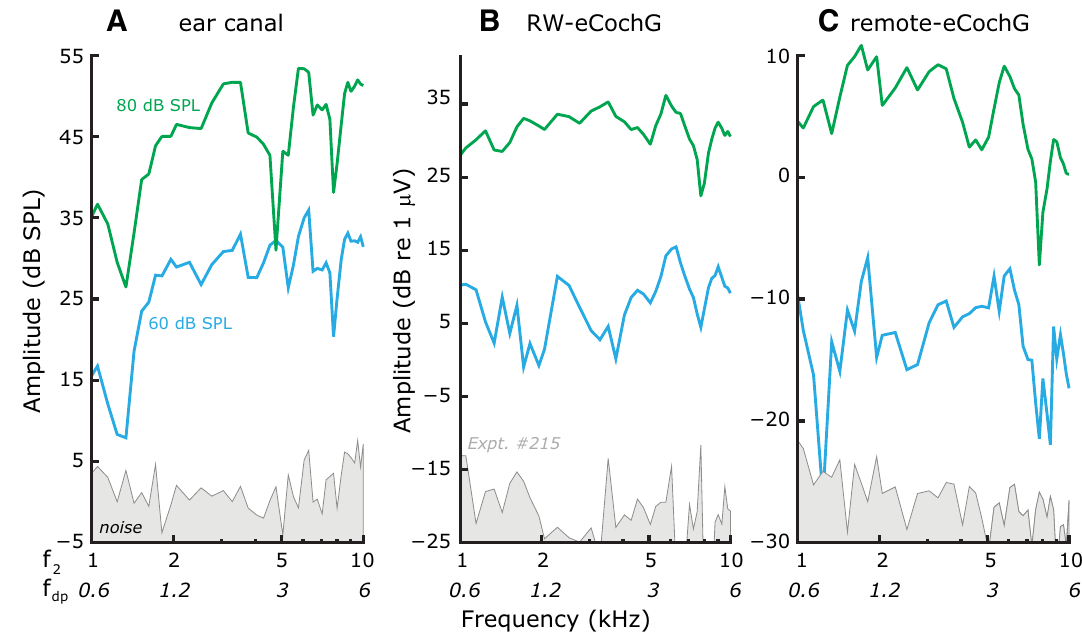
Figure 5. Distortion products (DP) in normal ears. Representative examples (Expt. #215) of DPs in ( A ) ear canal sound pressure (DPOAEs), ( B ) RW-eCochG, and ( C ) remote-eCochG. The three measures were taken simultaneously. DPs were evoked by presenting two stimulus tones that had their frequency ratio f 2 /f 1 fixed at 1.25. The levels for the two stimulus tones were equal at L 1 = L 2 = 60 ( blue lines ) or 80 dB SPL ( green lines ), respectively.